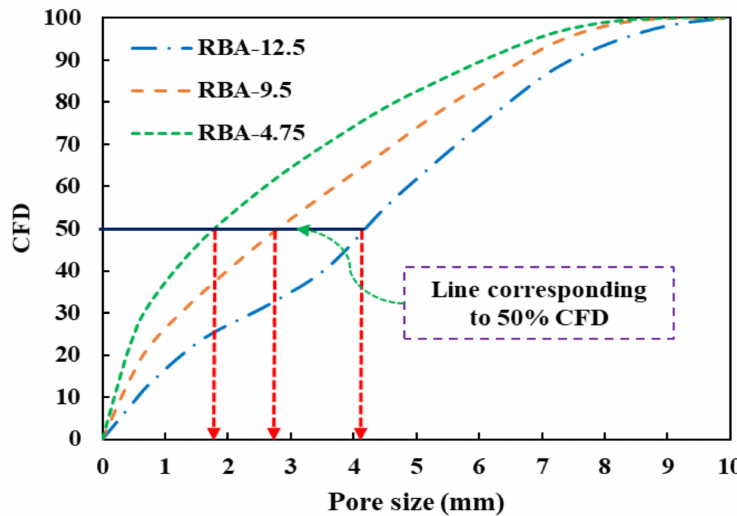
Figure 9. Frequency distribution and pore size calculation.